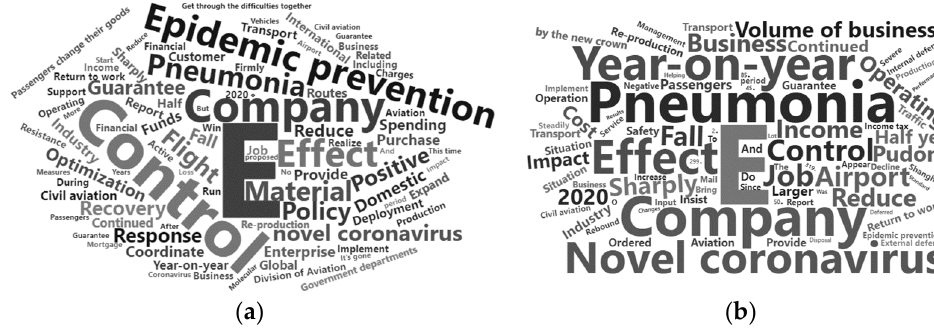
Figure 5. ( a ) Word Clouds Related to Epidemic in the Semiannual Report of Shenzhen Airport. ( b ) Word Clouds Related to Epidemic in the Semiannual Report of Shanghai Airport. Note: E means epidemic.